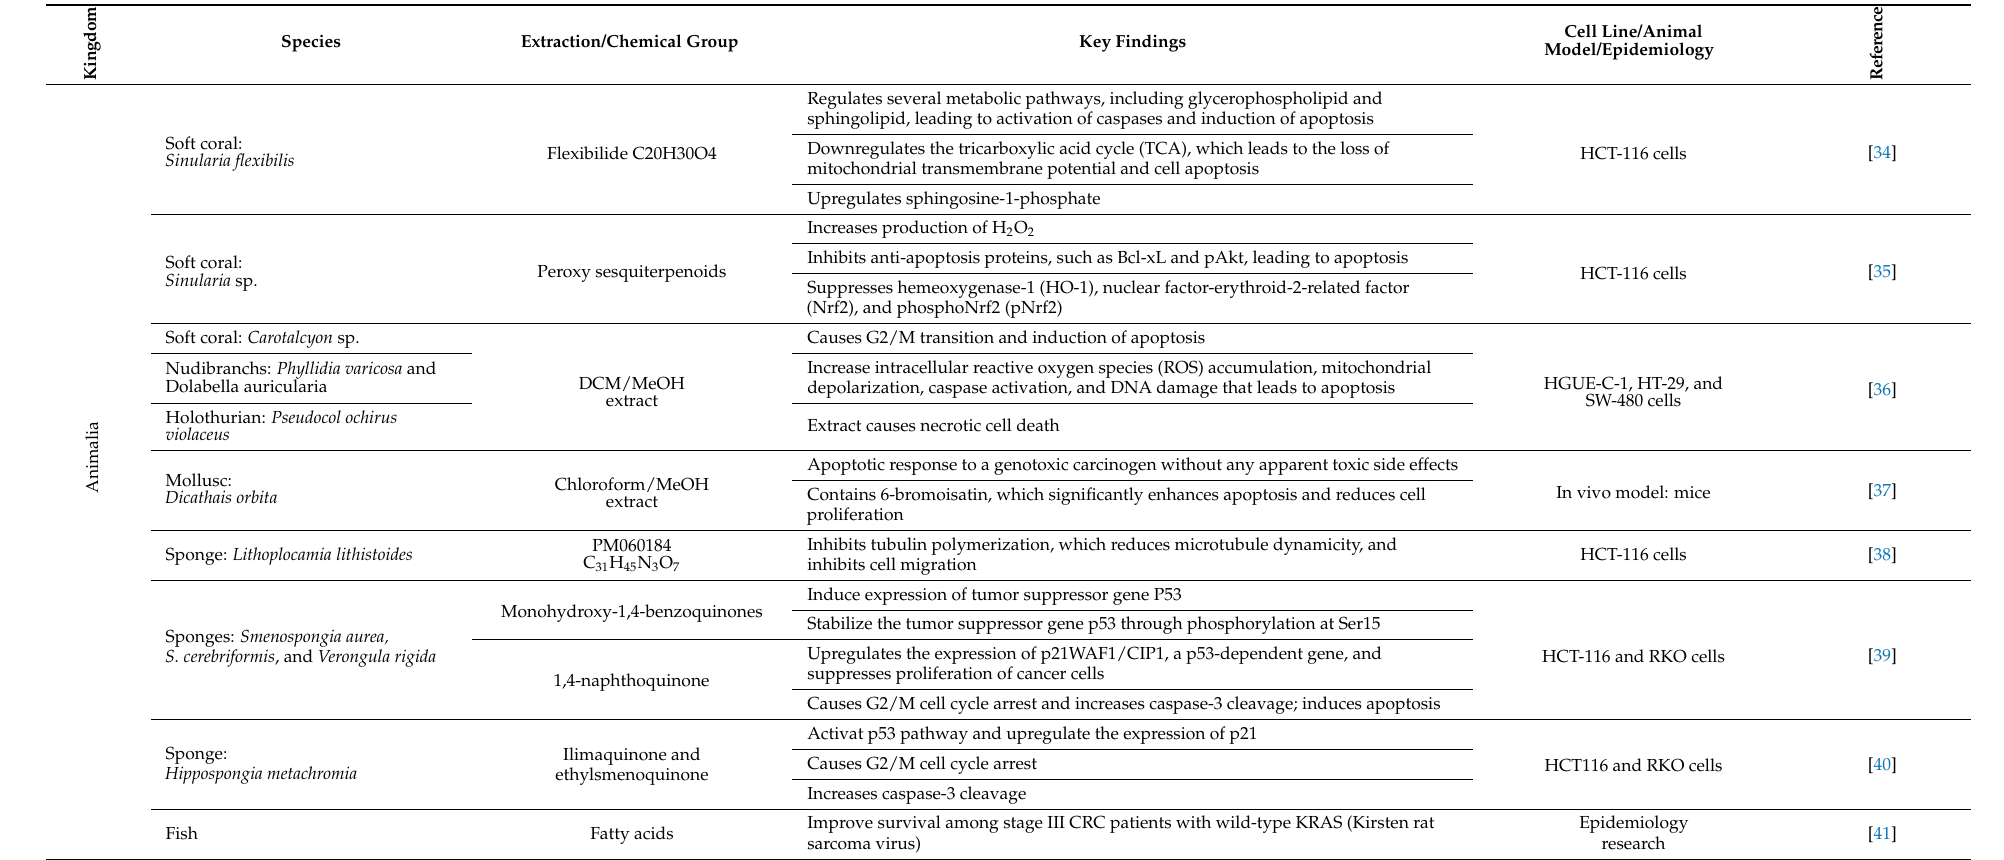
Table 1. Marine origin with anti-colorectal cancer